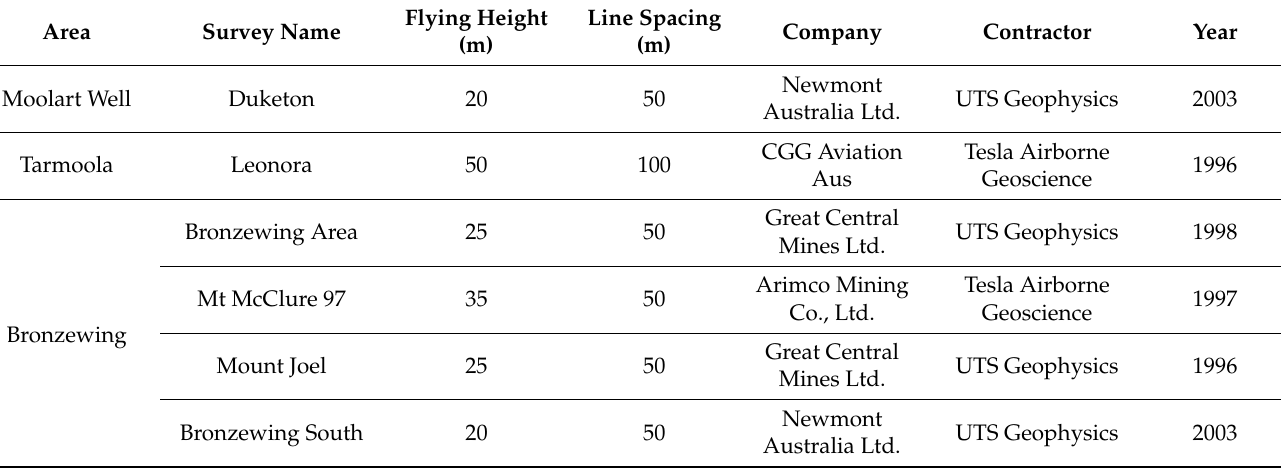
Table 1. Aeromagnetic surveys